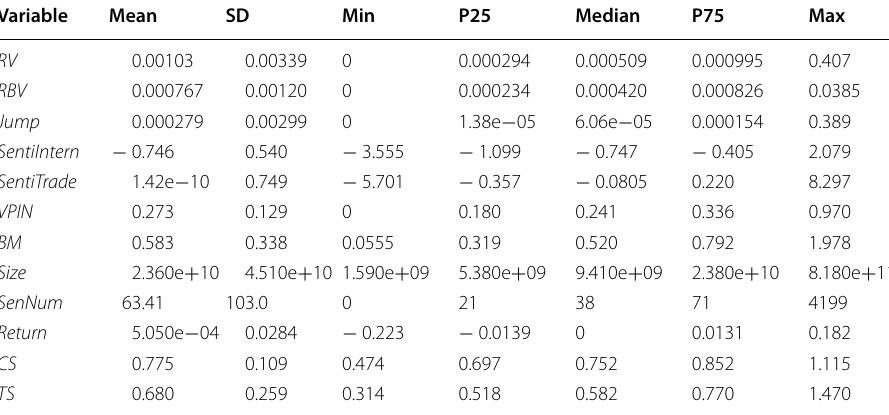
Table 2 Descriptive